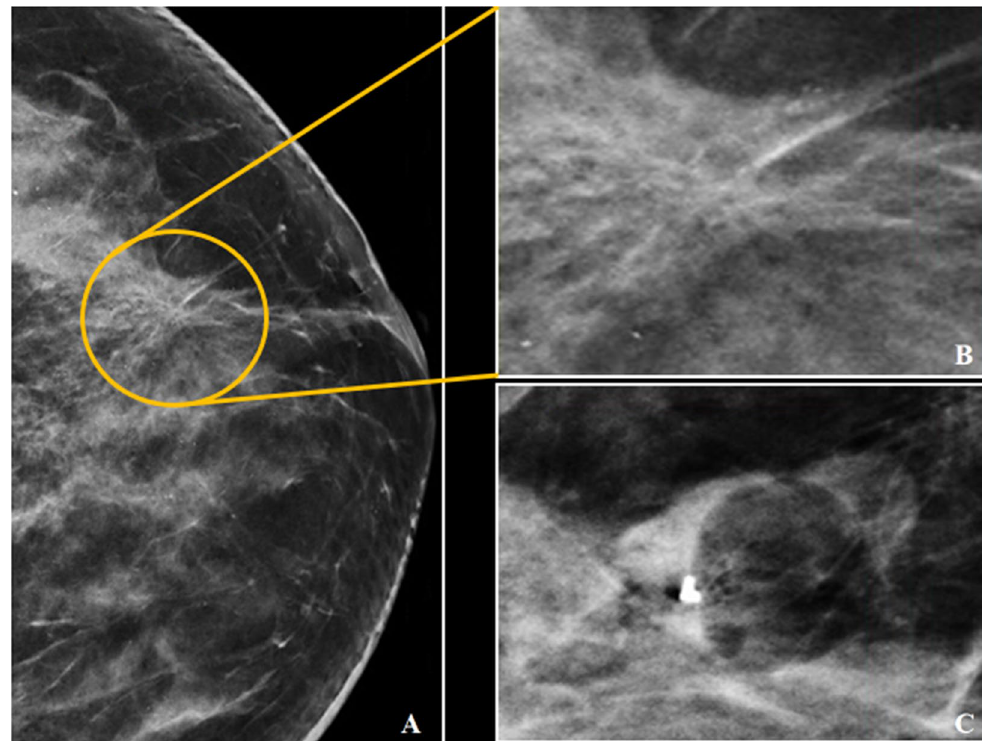
Figure 6. ( A–C ) A 42 year old lady with screen detected abnormality. The CC view of the left breast in C-view showed architectural distortion (yellow circle) in upper quadrant ( A ). Magnified view of region of interest as shown in ( B ). Post-VABB shows no residual lesion with resolved architectural distortion seen and post-biopsy change with biopsy marker in situ ( C ). VABB HPE revealed ADH and was upgraded to high-grade DCIS in the subsequent